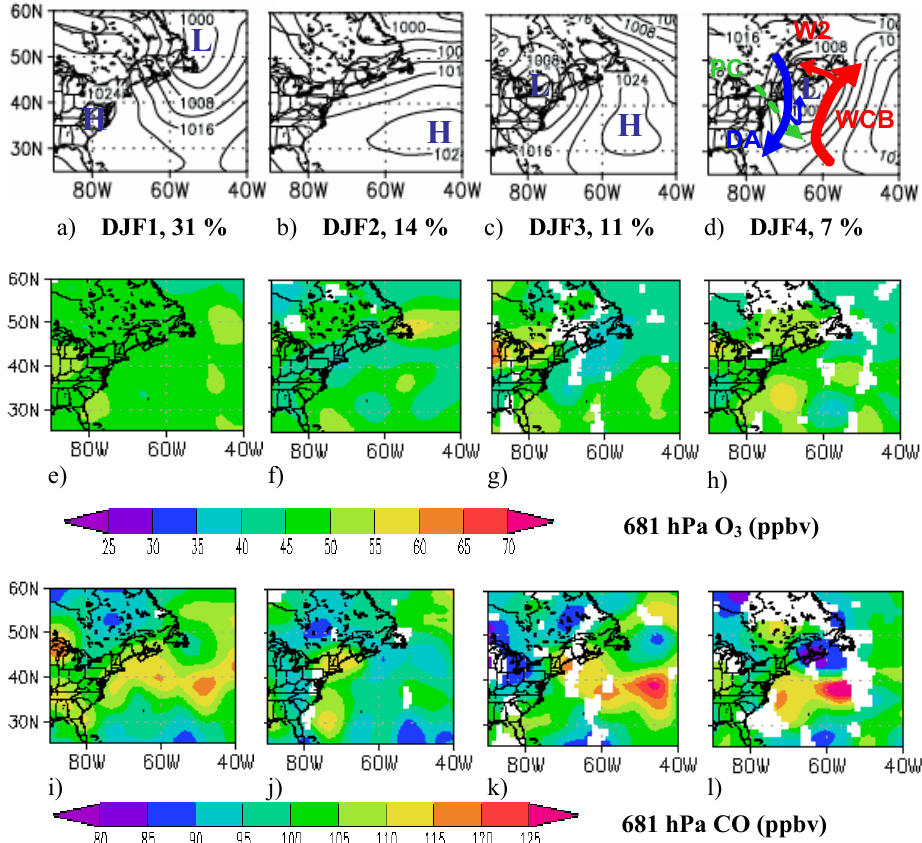
Fig. 4. Mean sea level pressure (SLP) (hPa) analyses for map types DJF1 – DJF4 during 2005 and 2006 (a–d) , corresponding TES composites for 681hPa O 3 (ppbv) (e–h) and 681hPa CO (i–l) . The frequencies for each map type are shown below the SLP